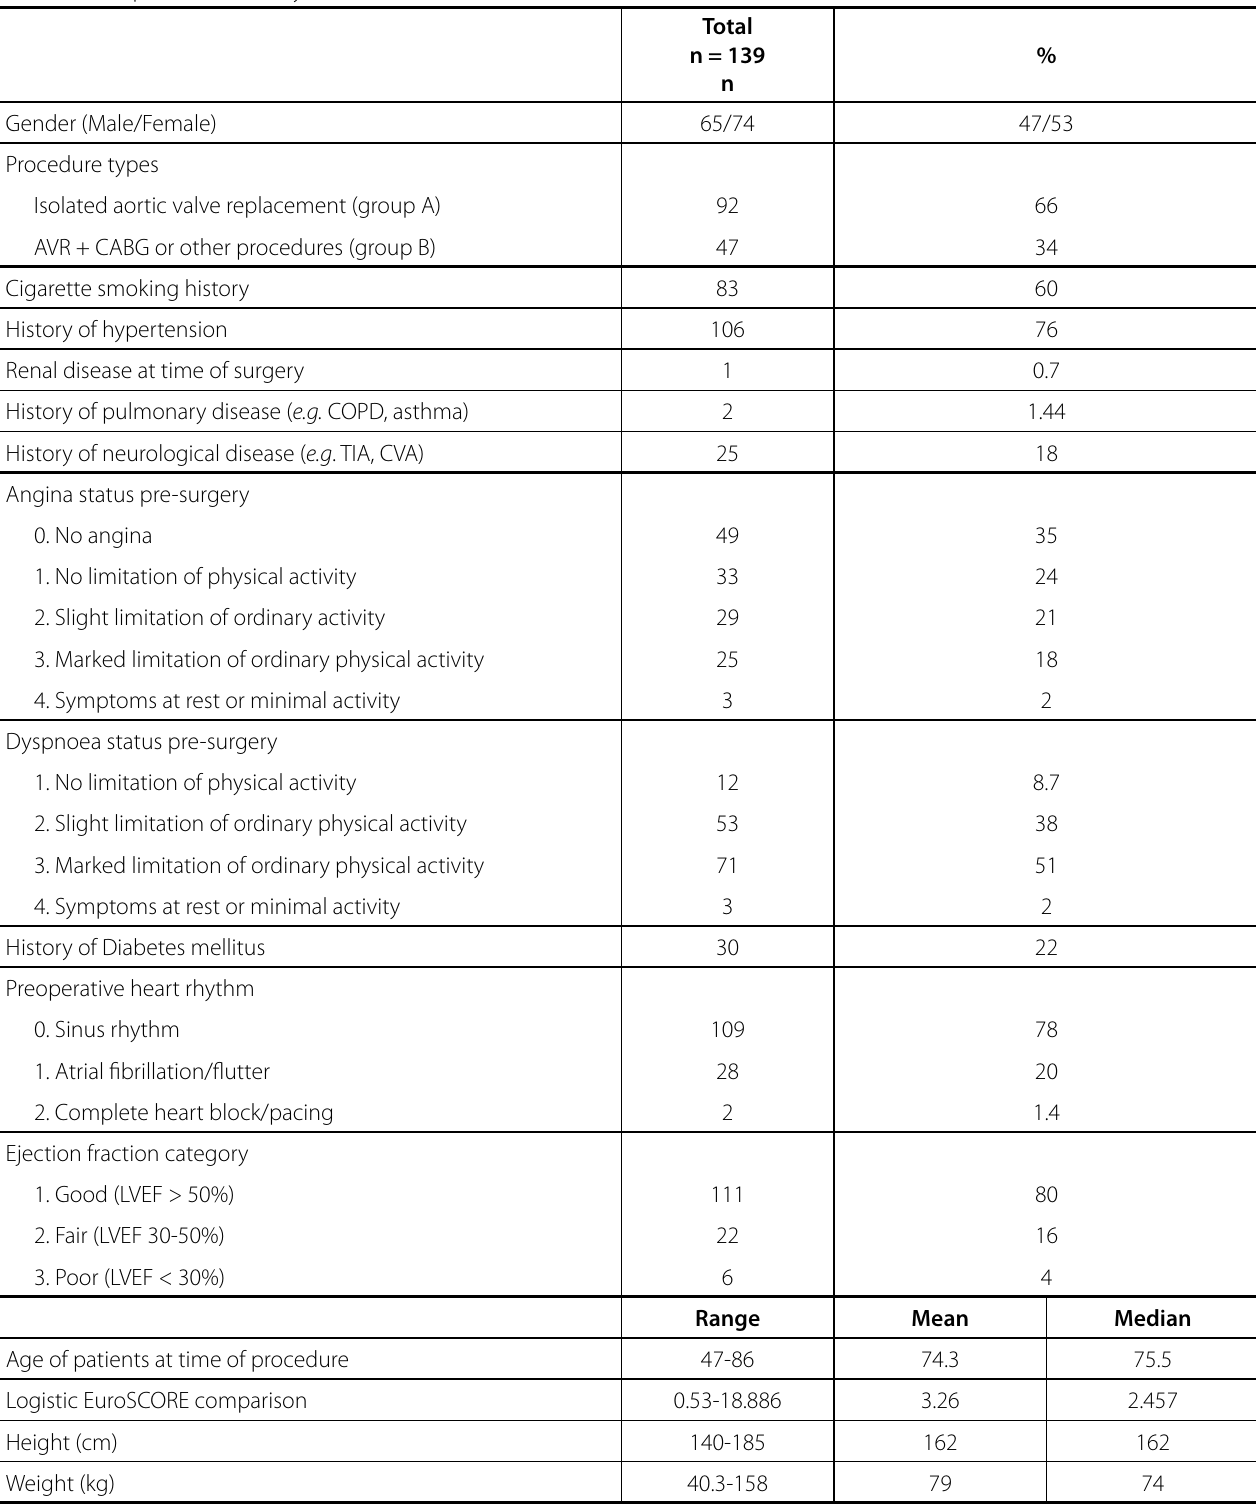
Table 1 . Preoperative